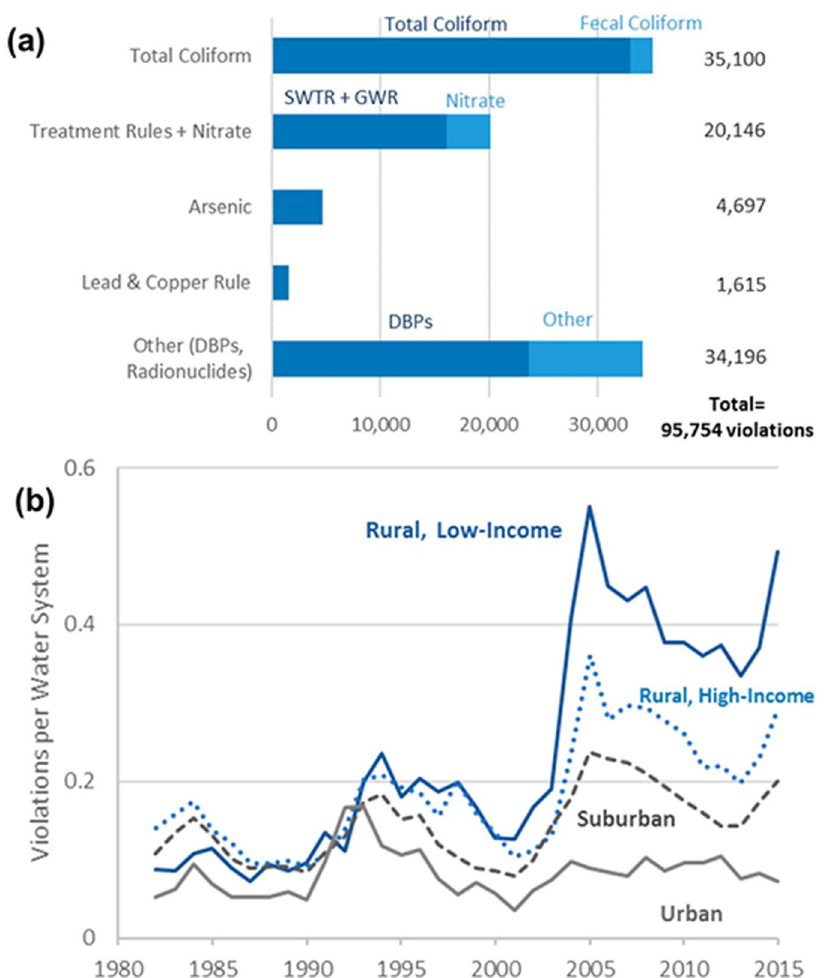
Fig. 1 Health-related violations of the Safe Drinking Water Act. a Number of health-based violations, and b total violations per water system. In total, 95,754 health-based violations were observed from 1982 to 2015, affecting up to 28% of US population. Rural areas have a larger compliance gap than suburban and urban areas; however, fewer violations with DBP violations were observed in rural areas with higher incomes (reprinted with permission from 33 ; Copyright © PNAS,